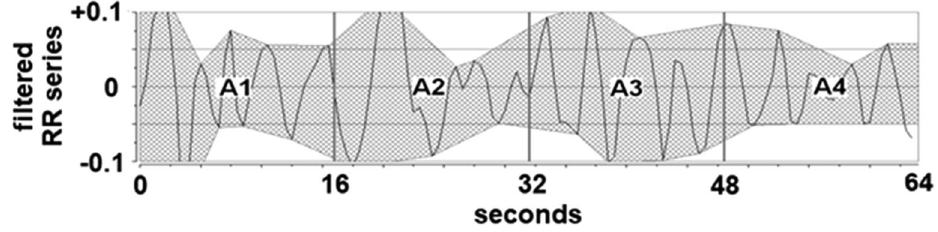
Figure 1. Centered, normalized and filtered RR series. A1, A2, A3 and A4 are the areas measuring the respiratory influence in the RR